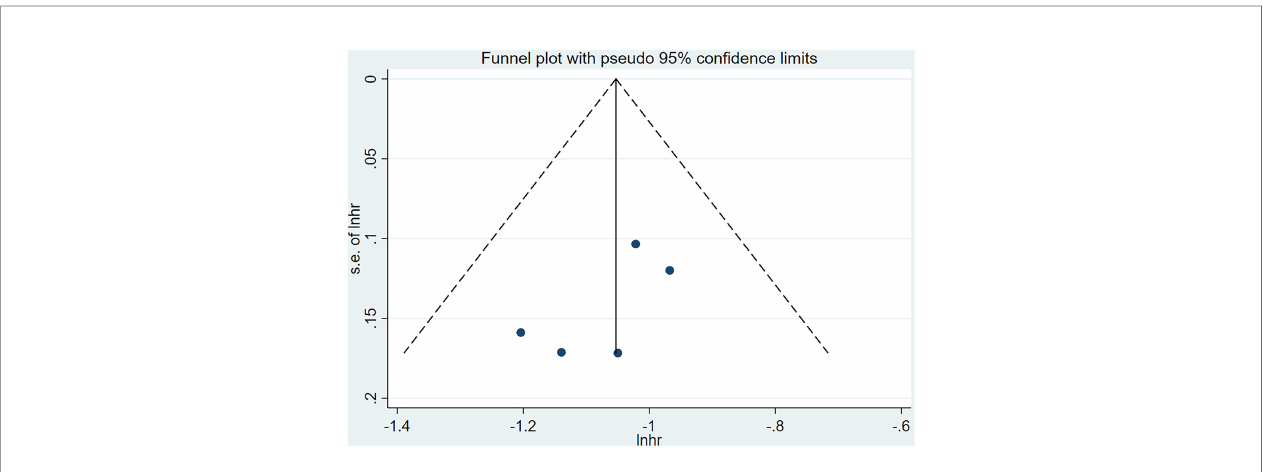
FIGURE 11 | Funnel plots for publication